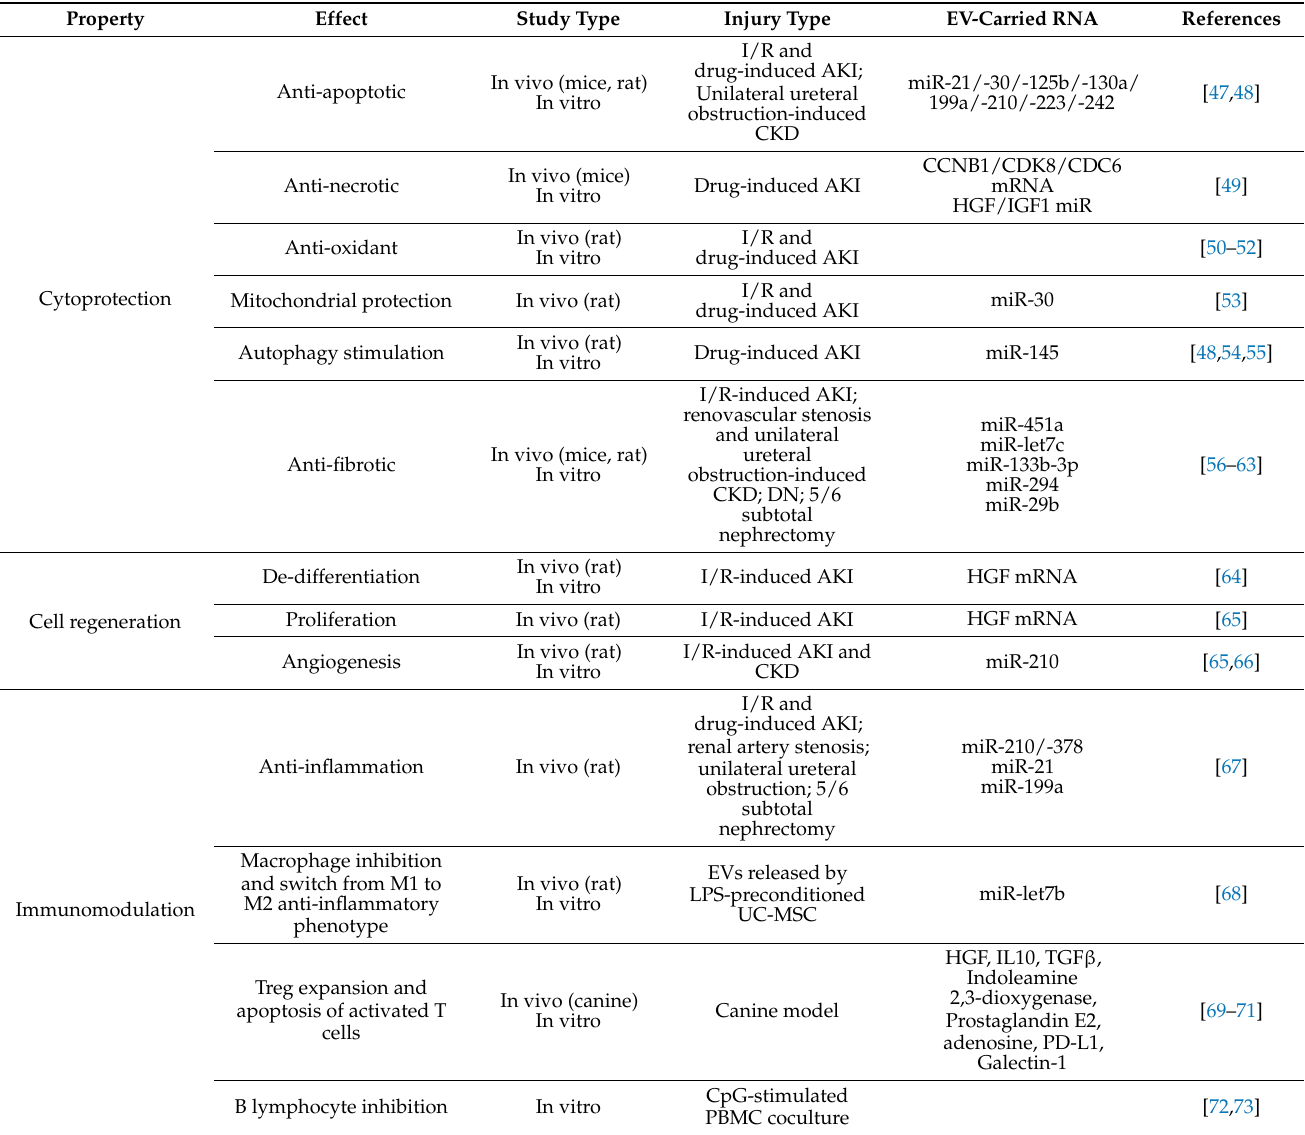
Table 1. General properties and potential mechanisms of MSC-derived EV therapy in different renal